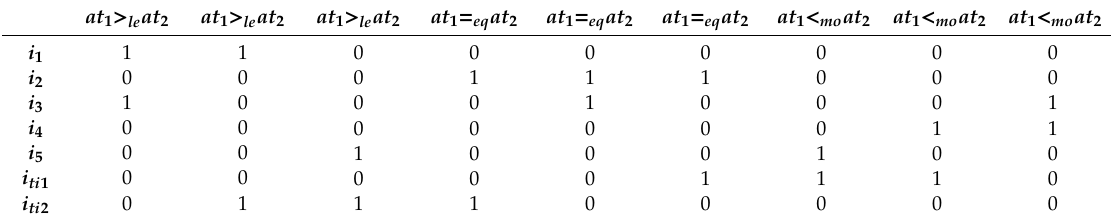
Table 4. Example of item interrelated attribute information table.